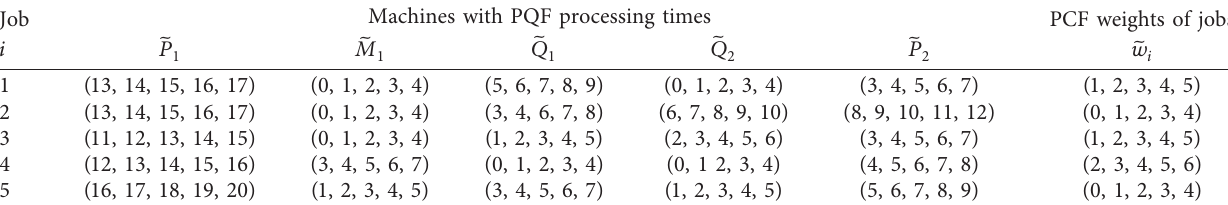
Table 8: Modified crisp break-down time of FS scheduling problem.